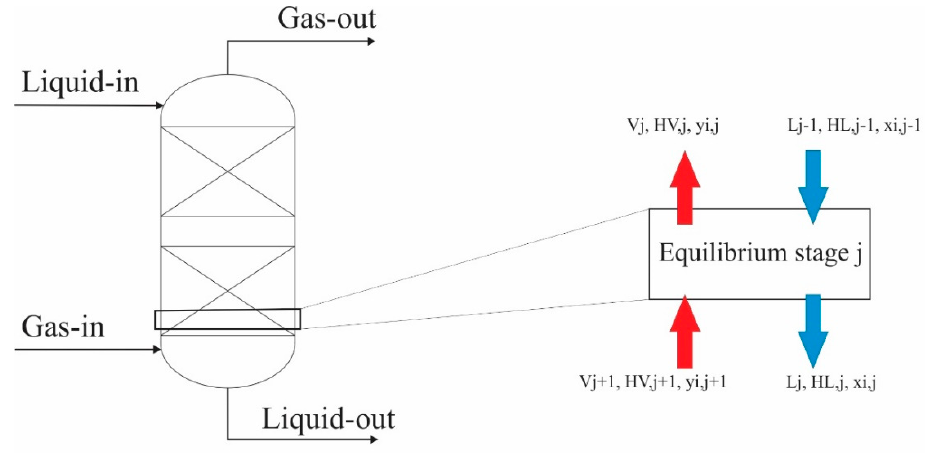
Figure 3. Equilibrium stage model